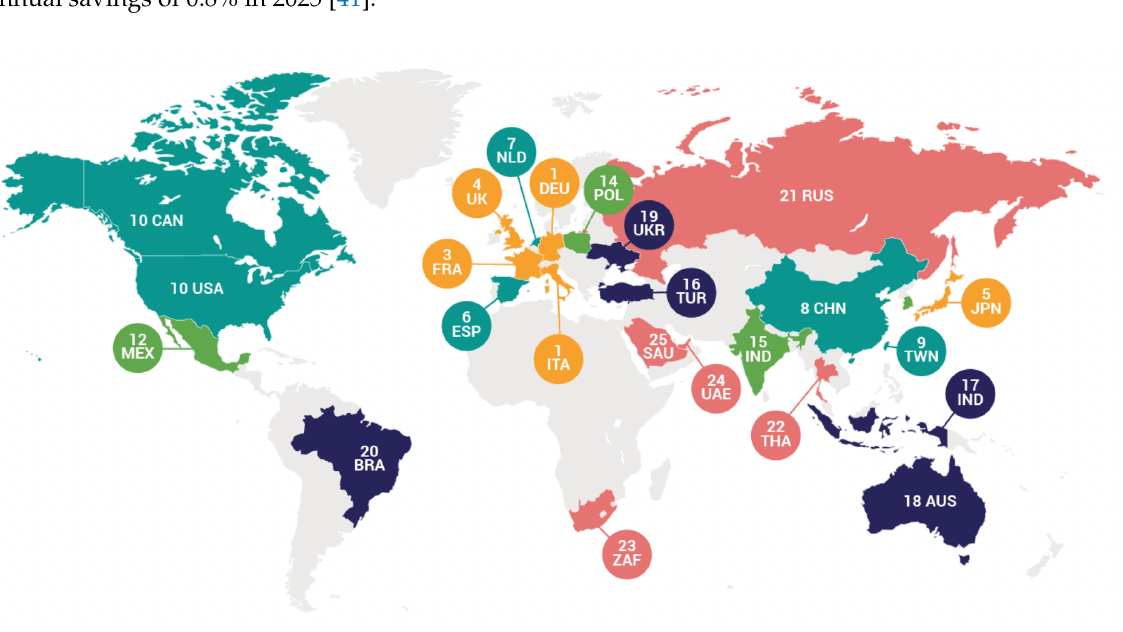
Figure 1. Rankings by country. Source: ACEEE